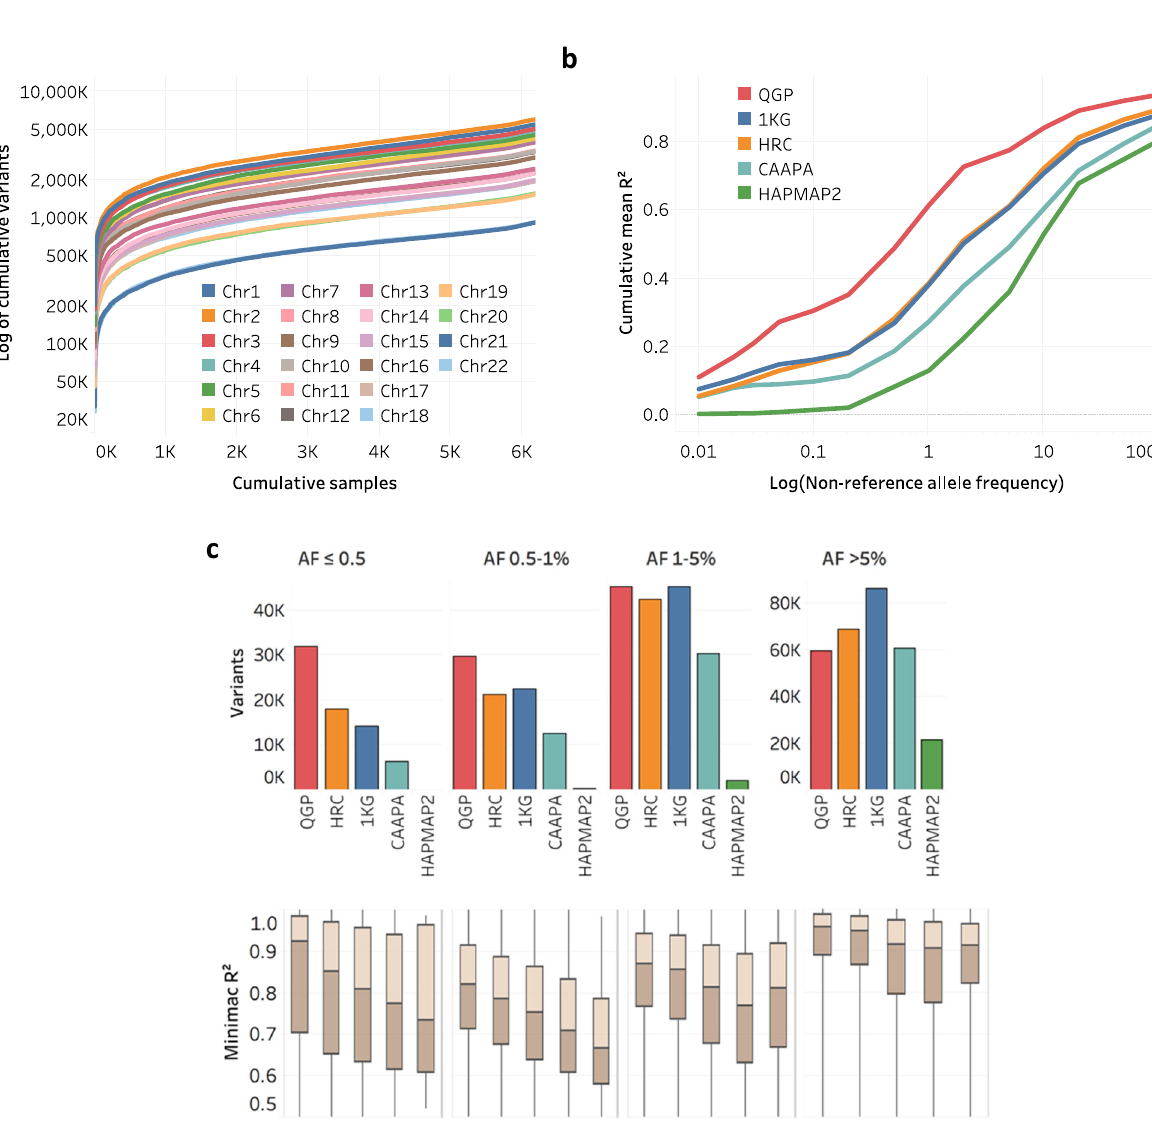
Fig. 7 Imputation using QGP versus other publicly available reference panels. a Cumulative variants (log of SNV count) discovered in the QGP phase 1 dataset as a function of cohort size. b Imputation performance of QGP panel versus panels of HRC, 1KG, CAAPA and HAPMAP2(https://imputation server.readthedocs.io/en/latest/reference-panels). Shown is imputation accuracy measured by cumulative mean R 2 when imputing SNP genotypes into 105 independent Qatari samples as a function of logarithm of non-reference allele frequency of imputed SNPs. The results are based on genotypes on Affymetrix 6 array as a pseudo-array data. c Number of imputed variants using various panels per category of predicted minor allele frequency (top) and respective distribution of high quality Minimac R 2 scores (>0.5) (bottom). Number of samples tested is n = 105. Boxes indicate median and middle two quartiles of the data. Whiskers indicate the range of the data. Source data are provided as a Source Data fi